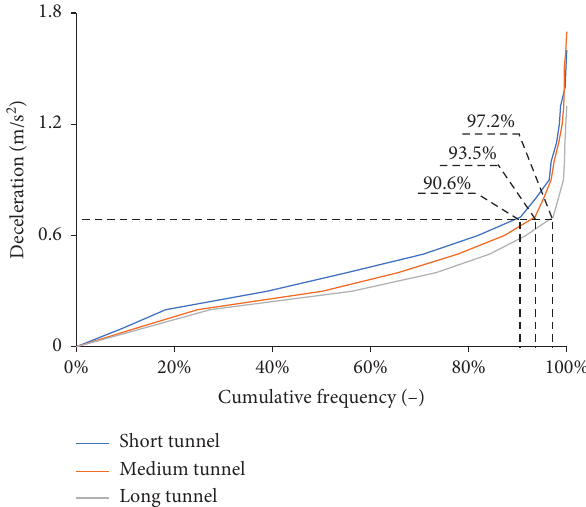
Figure 5: Cumulative frequency curves of deceleration rate under three tunnel length